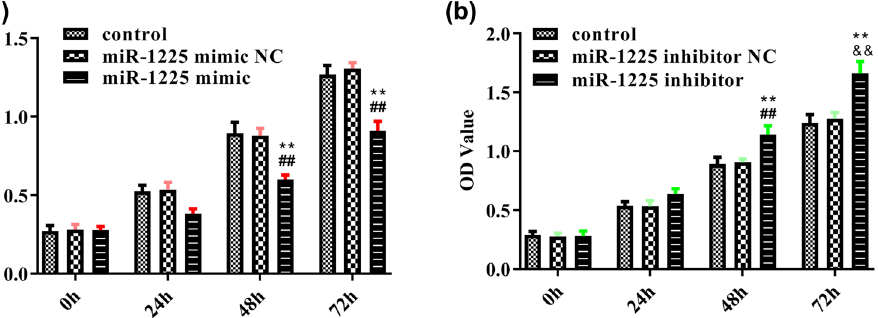
Figure 2: miR - 1225 - 5p inhibits cell viability in glioblastoma. CCK - 8 assay was performed to measure the e ff ect of ( a ) miR - 1225 - 5p mimic on U87 cell viability and ( b ) miR - 1225 - 5p inhibitor in U251 cell viability. ** P < 0.01 vs control group. ## P < 0.01 vs miR - 1225 - 5p mimic NC group. && P < 0.01 vs miR - 1225 - 5p inhibitor NC